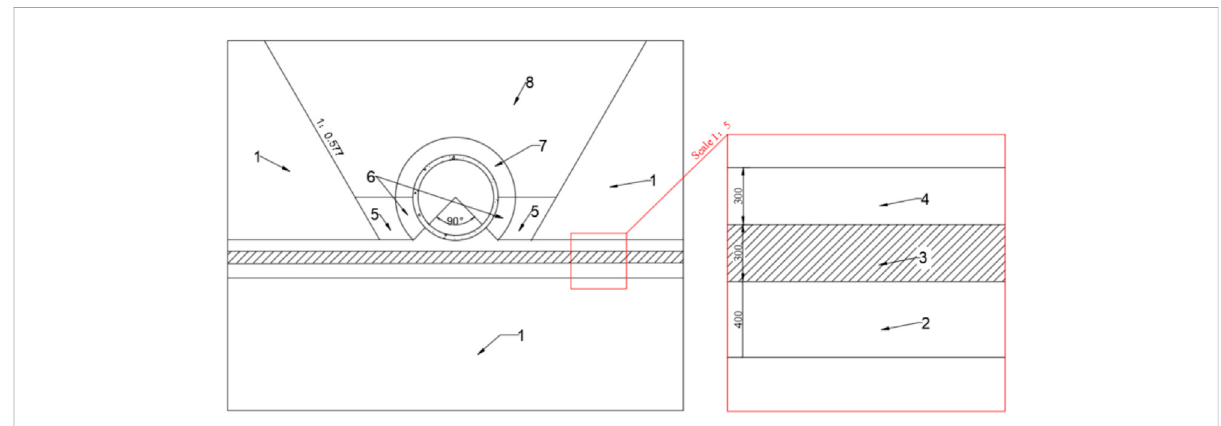
FIGURE 5 Partition of the surrounding soil of PART B: (1) stereogram of the soil; (2) front view of part B as follows: 1 — undisturbed section; 2 — light disturbed section; 3 — moderately disturbed section; 4 — severely disturbed section; 5 — bottom fi ll-back; 6 — cradle section; 7 — buffer section; and 8 — upper fi ll-back (Dimension: